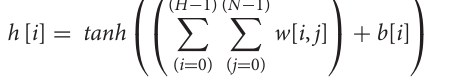
Equation 5. Deep neural network equation using tanh non-